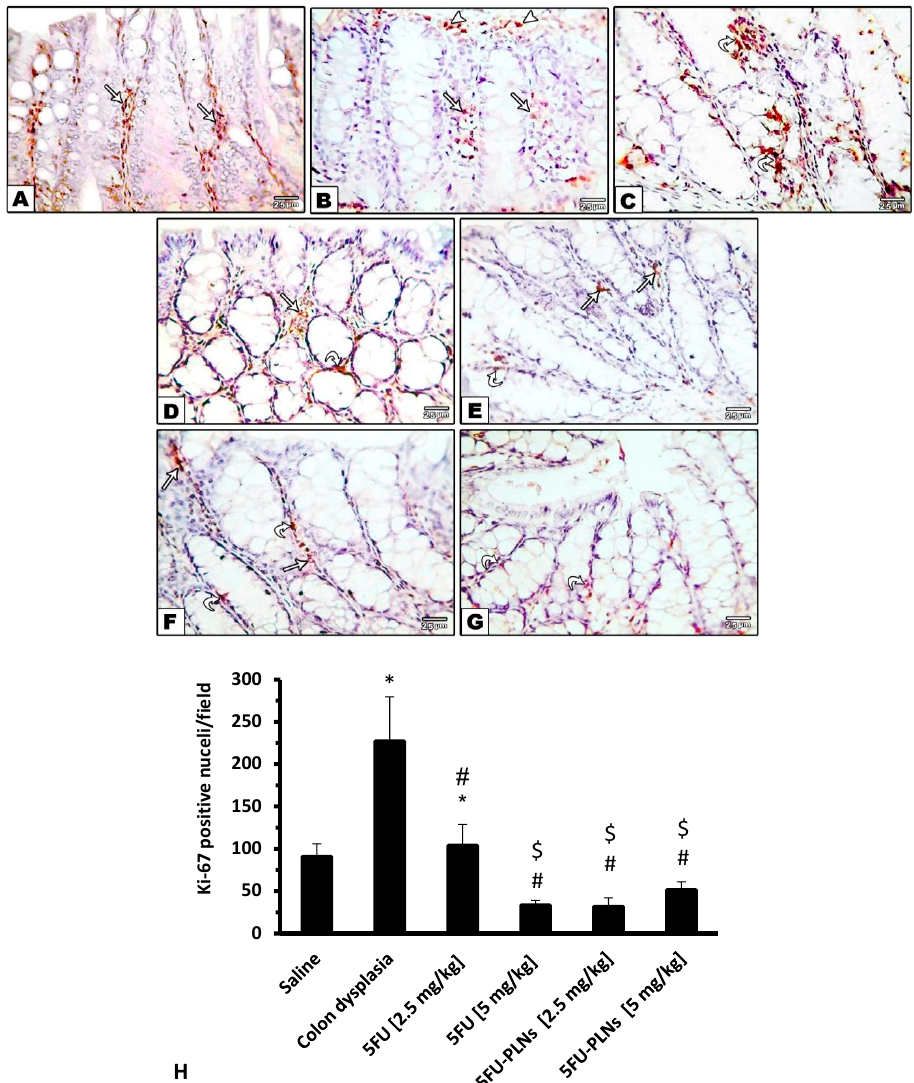
Figure 9. Microscopic pictures of immunohistochemical staining against Ki-67 of colon sections. Images for saline group ( A ), Colon dysplasia control group ( B , C ), FU [2.5 and 5 mg/kg] treated group ( D , E ), 5FU-PLNs [2.5 and 5 mg/kg] treated groups ( F , G ). Positive expression appears as brown nuclear staining of surface epithelial cells (arrow heads), crypt lining cells (straight arrows), and proliferating interstitial cells (curved arrows). Immunohistochemistry counterstained with Mayer’s hematoxylin X400. ( H ) Mean number of Ki-67 positive nuclei in experimental groups measured using VideoTest Morphology ® software (Saint-Petersburg, Russia) and presented as mean ± SDM and compared at p less than 0.05. *: Versus saline group; #: Versus colon hyperplasia control group; $: Versus 5FU [2.5 mg/kg]